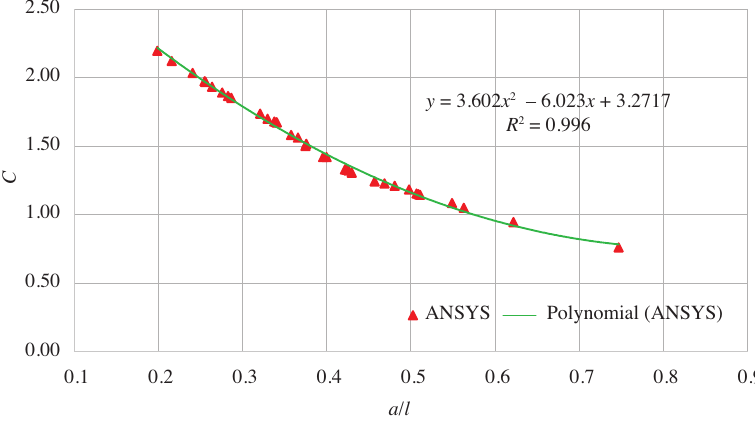
Figure 14. Interpolating curve of C values